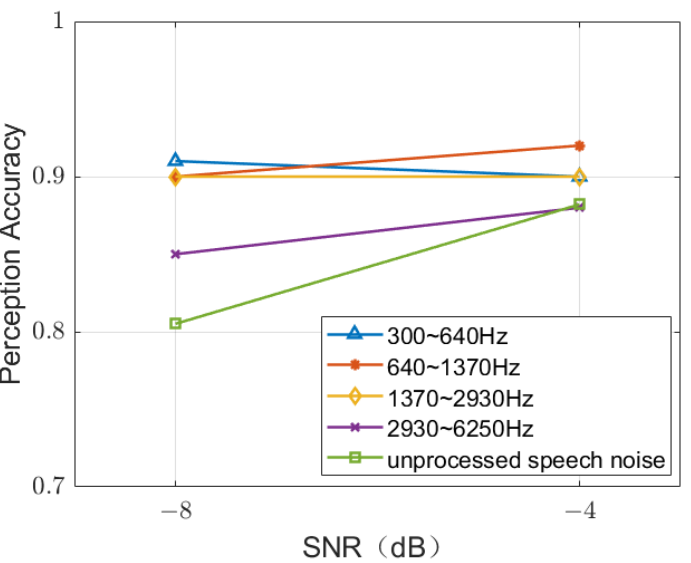
Figure 6. The results of the voice identity perception in four speech noise environments with differ- ent frequency bands